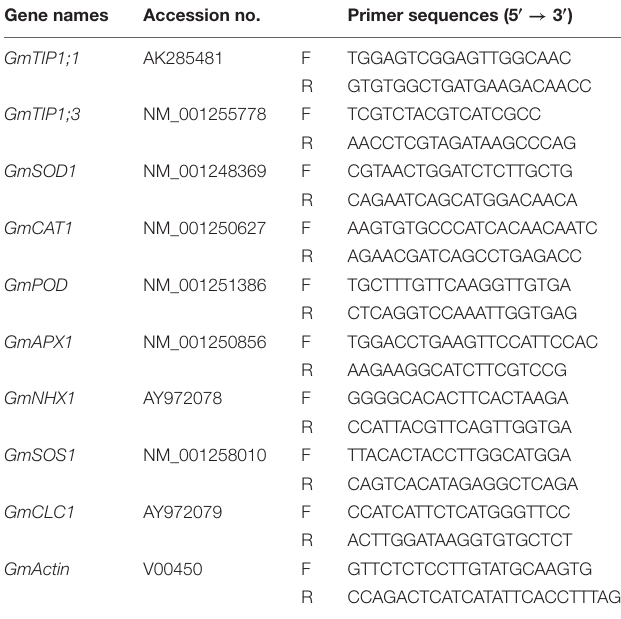
TABLE 1 | Primers for RT-PCR of the stress-related